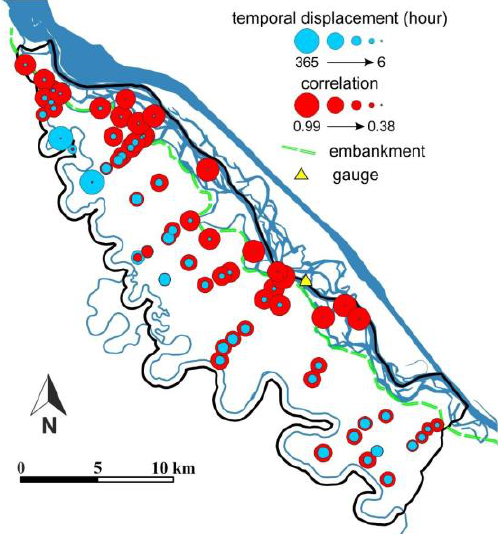
Figure 2. The results of cross-correlation between the water level time series of wells and the Danube gauge. As distance from the river increases, the maximum value of the correlation coefficient diminishes, while the degree of temporal displacement related to the given coefficients also increases.